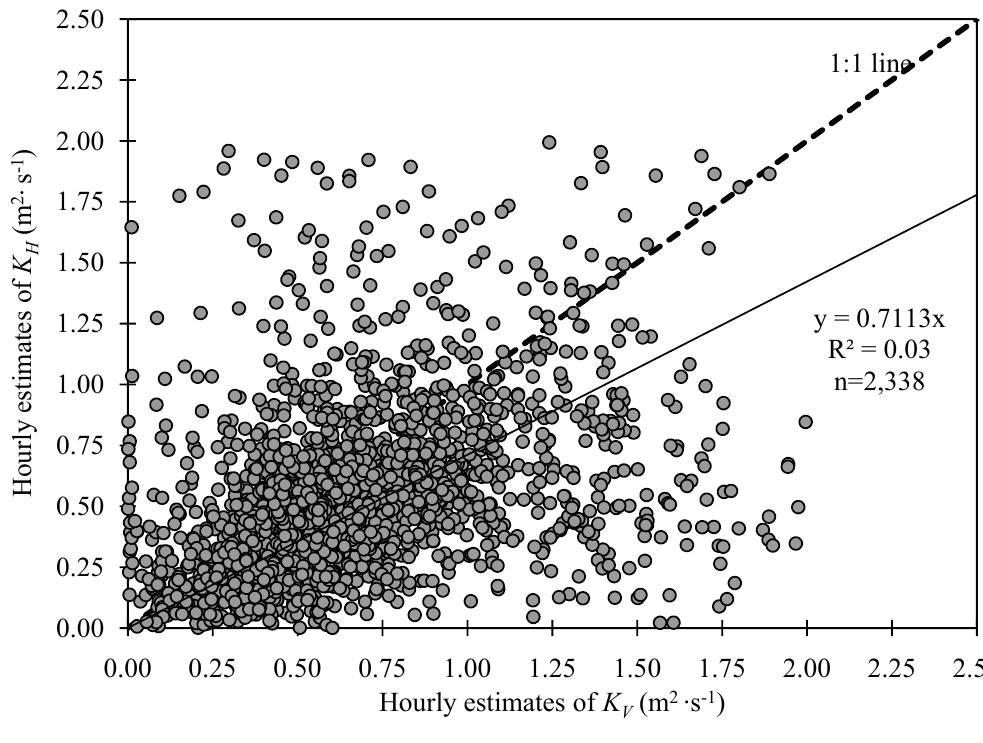
Figure 1. Hourly estimates of K seasons in 2005 and 2006 (pooled